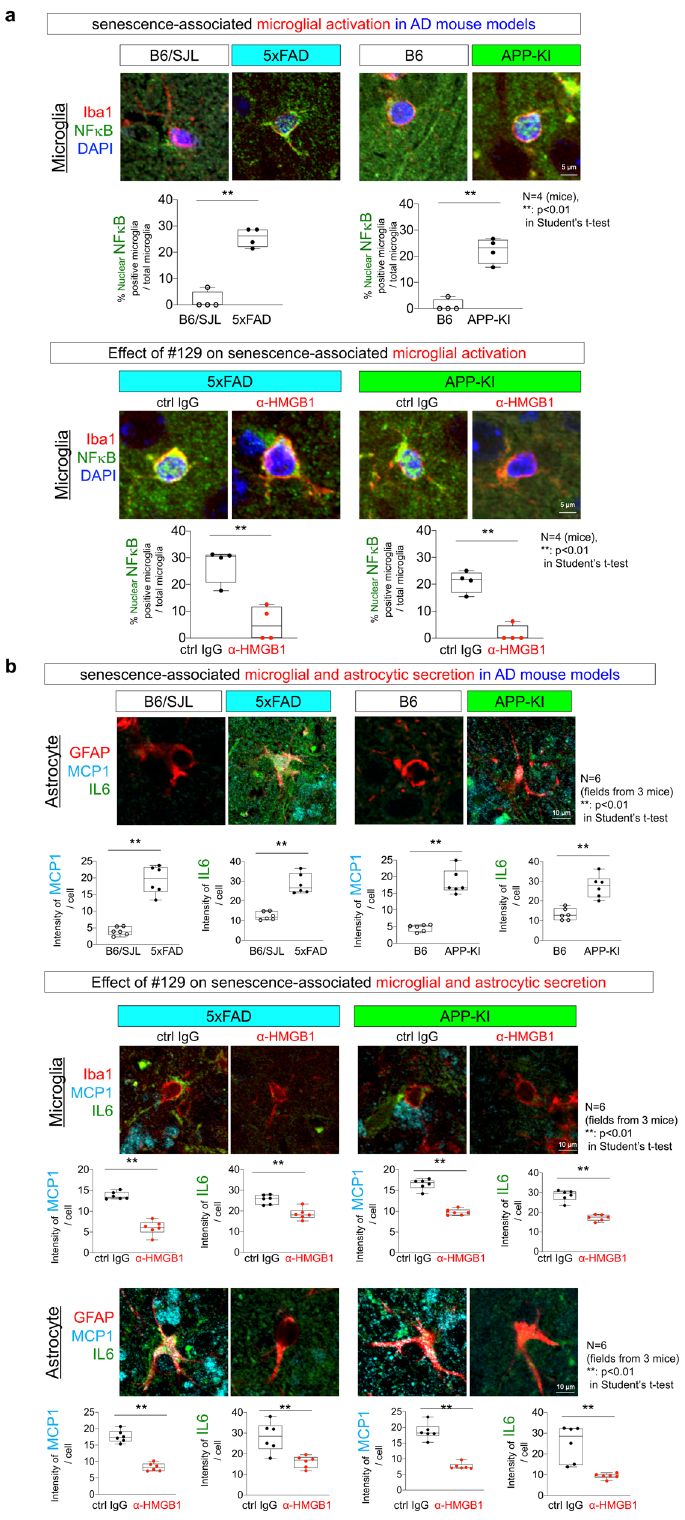
Fig. 9 Suppression of glial senescence by anti-HMGB1 antibody. a The ratio of activated microglia in which NF κ B were translocated to the nucleus was increased in 5xFAD and APP-KI mice at 8 months of age (upper panels). Microglia in the occipital cortex were counted in a visual fi eld of a slide made from each mouse ( N = 4). Activated microglia with nuclear NF κ B were suppressed in 5xFAD and APP-KI mice by intravenous injection of human monoclonal anti-HMGB1 antibody (#129) according to the protocol in Fig. 6 (lower panels). b Secretion of SASP (MCP1 and IL-6) was increased in 5xFAD and APP-KI mice at 8 months of age (upper panels). Signal intensities of MCP1 and IL-6 were acquired in the circular area of 50 μ m diameter surrounding a cell. The average value was calculated with their signal intensities of multiple circular areas in two visual fi elds derived from each mouse ( N = 3). Secretion of SASP was suppressed in 5xFAD and APP-KI mice by intravenous injection of human monoclonal anti-HMGB1 antibody (#129) according to the protocol in Fig.